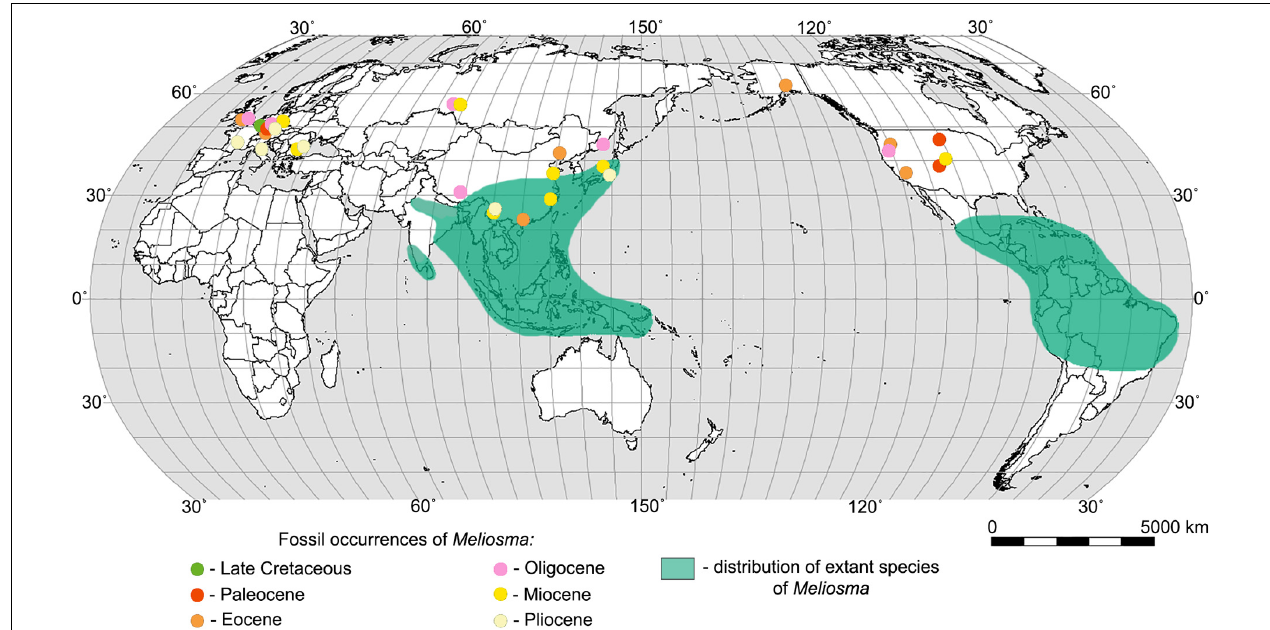
FIGURE 1 | World map showing the distribution of extant species of Meliosma (according to Van Beusekom, 1971) and the main fossil sites of Meliosma .